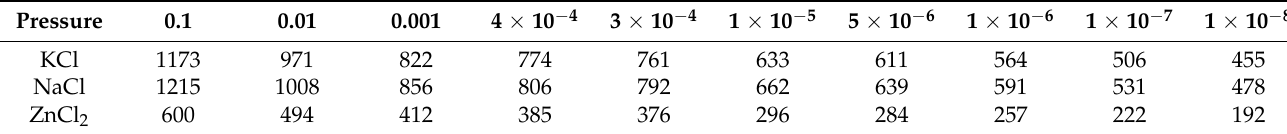
Figure 9. Standard Gibbs energies of the chlorination at different temperatures. ZnCl 2 and PbCl 2 completely volatilized at 1200 °C due to their low boiling points of 732 and 951 °C, respectively. Although NaCl and KCl have high boiling points of 1516 and 1475 °C, respectively, they correspond to high saturated partial pressures at high temperatures, as shown in Table 3. Thus, the chlorides were vaporized and entered their gas phases at high temperatures. The high-temperature section favored the separation of chlorides from the solid materials. Table 3. Vapor pressures (atm) corresponding to dew temperatures (°C).